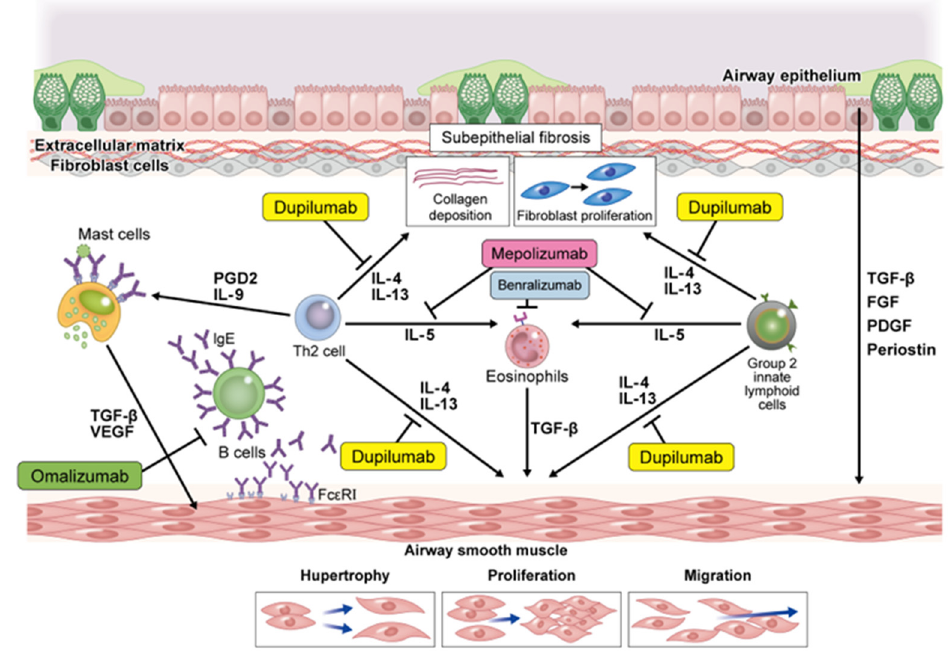
Figure 3. Induction of Th2 cytokines for airway remodeling and suppression by biological drugs.